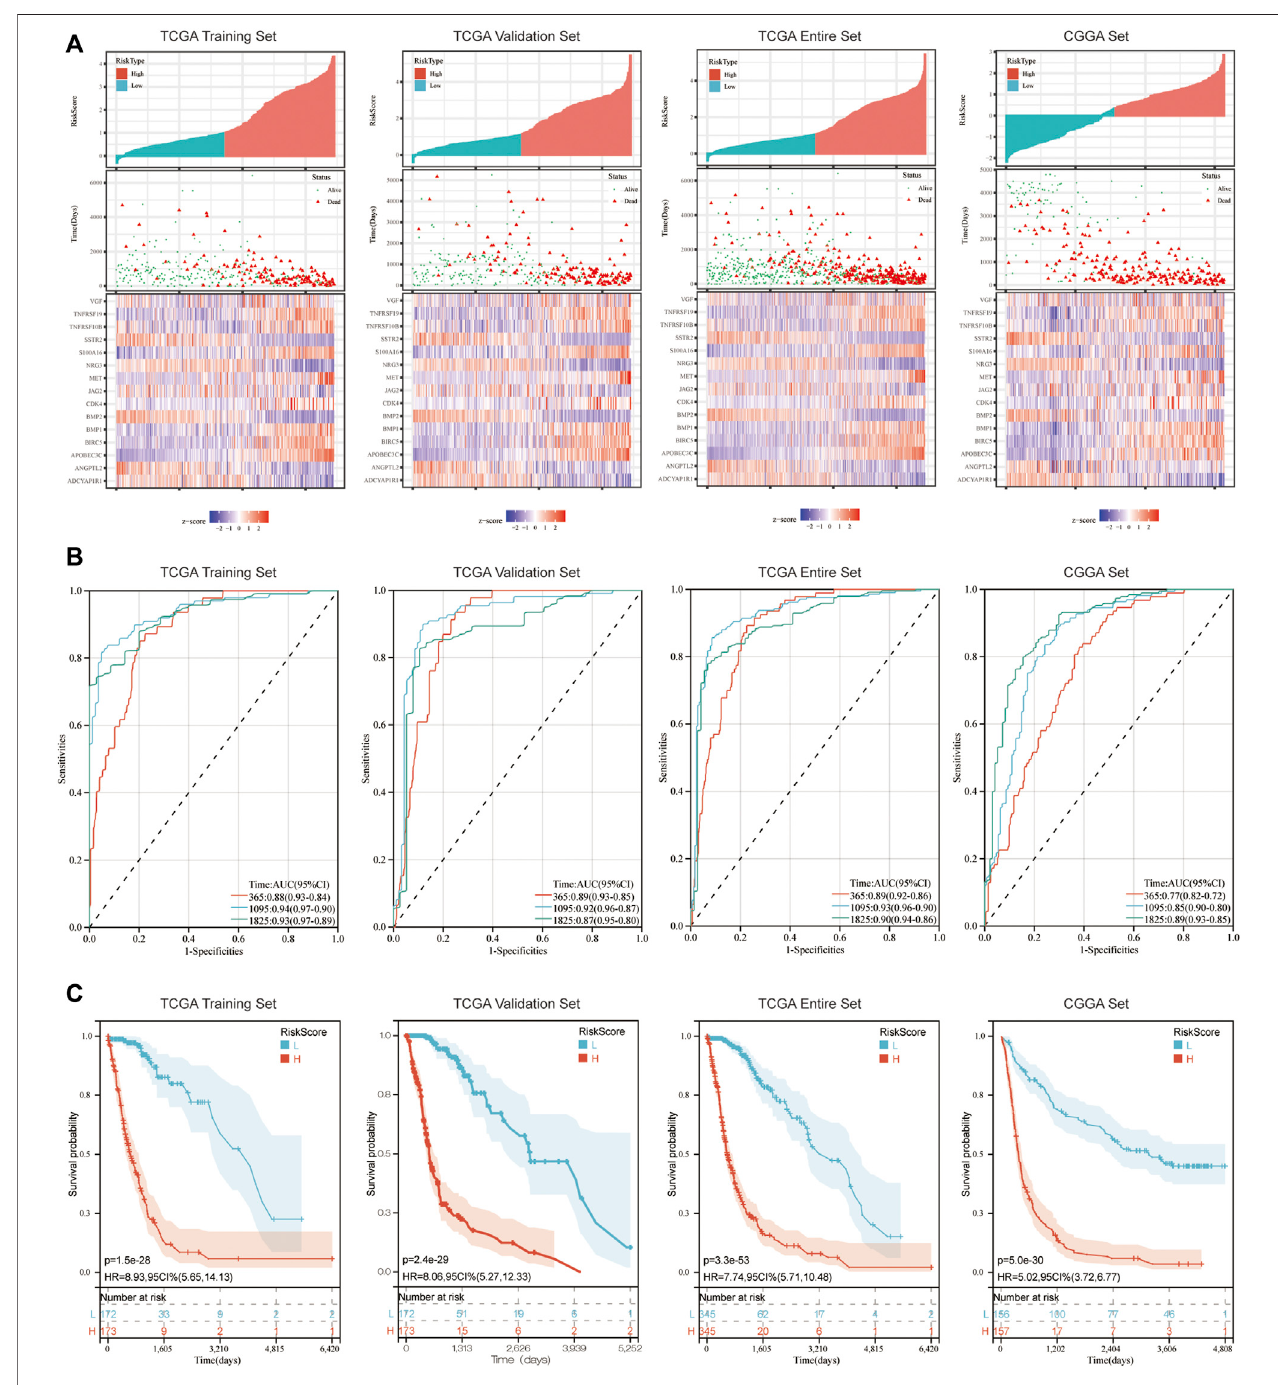
FIGURE2| Immune-relatedsignatureeffectivelypredictstheprognosisofpatientswithglioma. (A) Riskscoredistribution,survivalstatusandexpressionof15hub genes for glioma in low-risk and high-risk groups. (B) 1, 3 and 5-year ROC curve analyses. ROC, receiver operating characteristic. (C) K-M survival curve analyses.